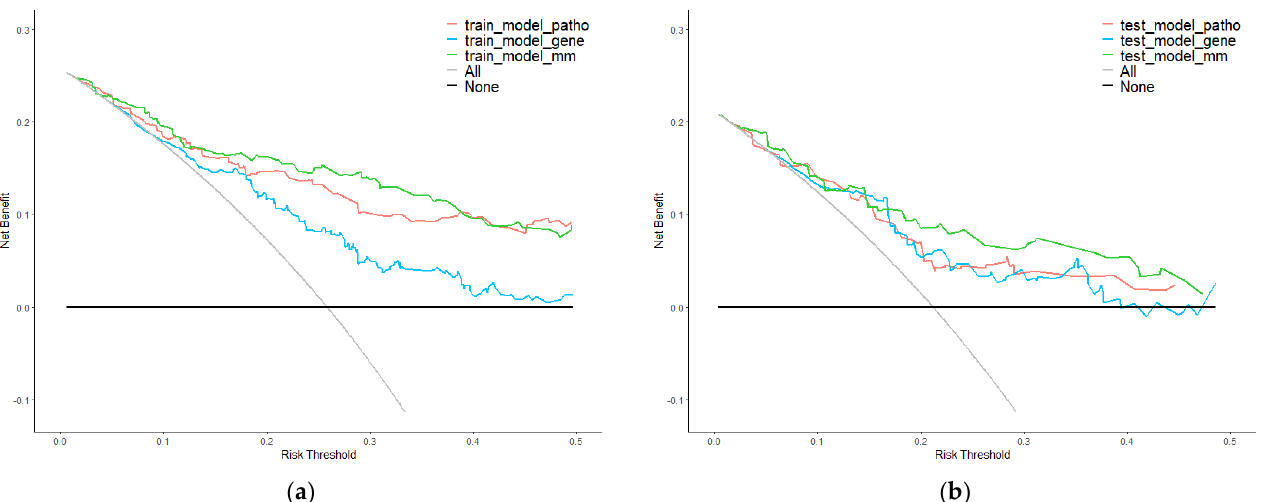
Figure 6. Decision curve analysis (DCA) of single − modality and multi − modality models. ( a ) DCA for models of survival prediction on the training set. ( b ) DCA for models of survival prediction on the test set. Red, blue, and green plots represent pathology, gene, and multi − modality modes. Grey and black plots are two net benefit reference lines in an extreme situation.